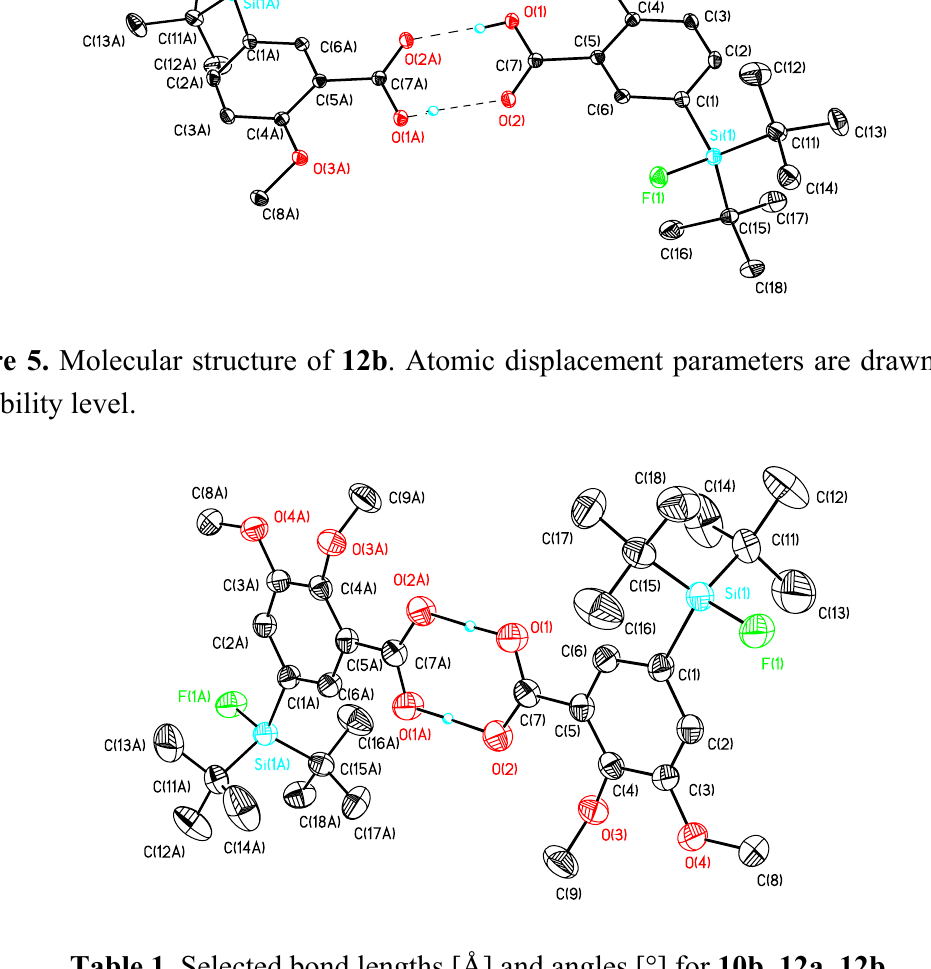
Table 1. Selected bond lengths [Å] and angles [°] for 10b , 12a , 12b